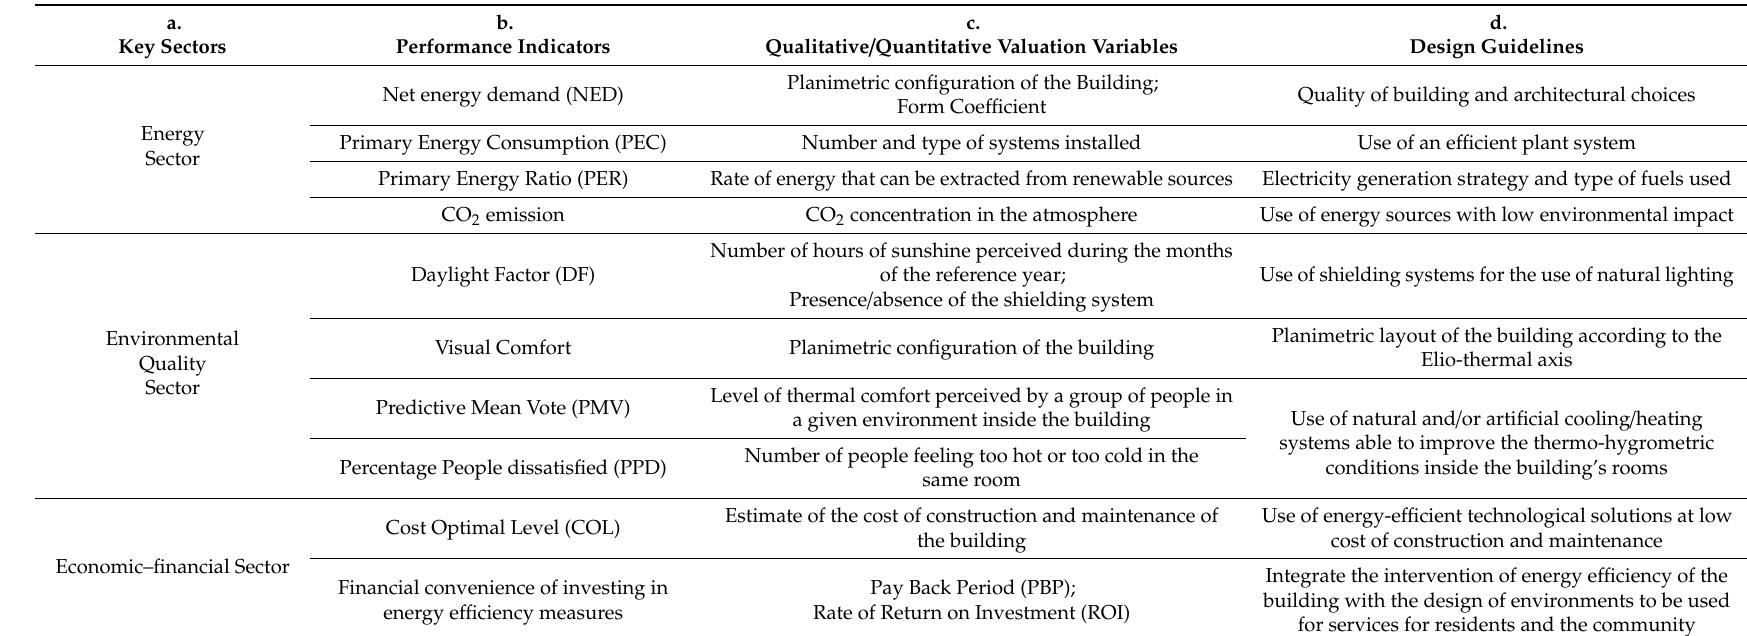
Table 1. Energy performance indicator